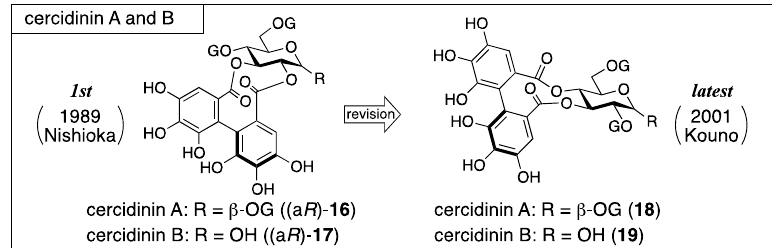
Figure 9. The transition of the structure of cercidinin A and B.